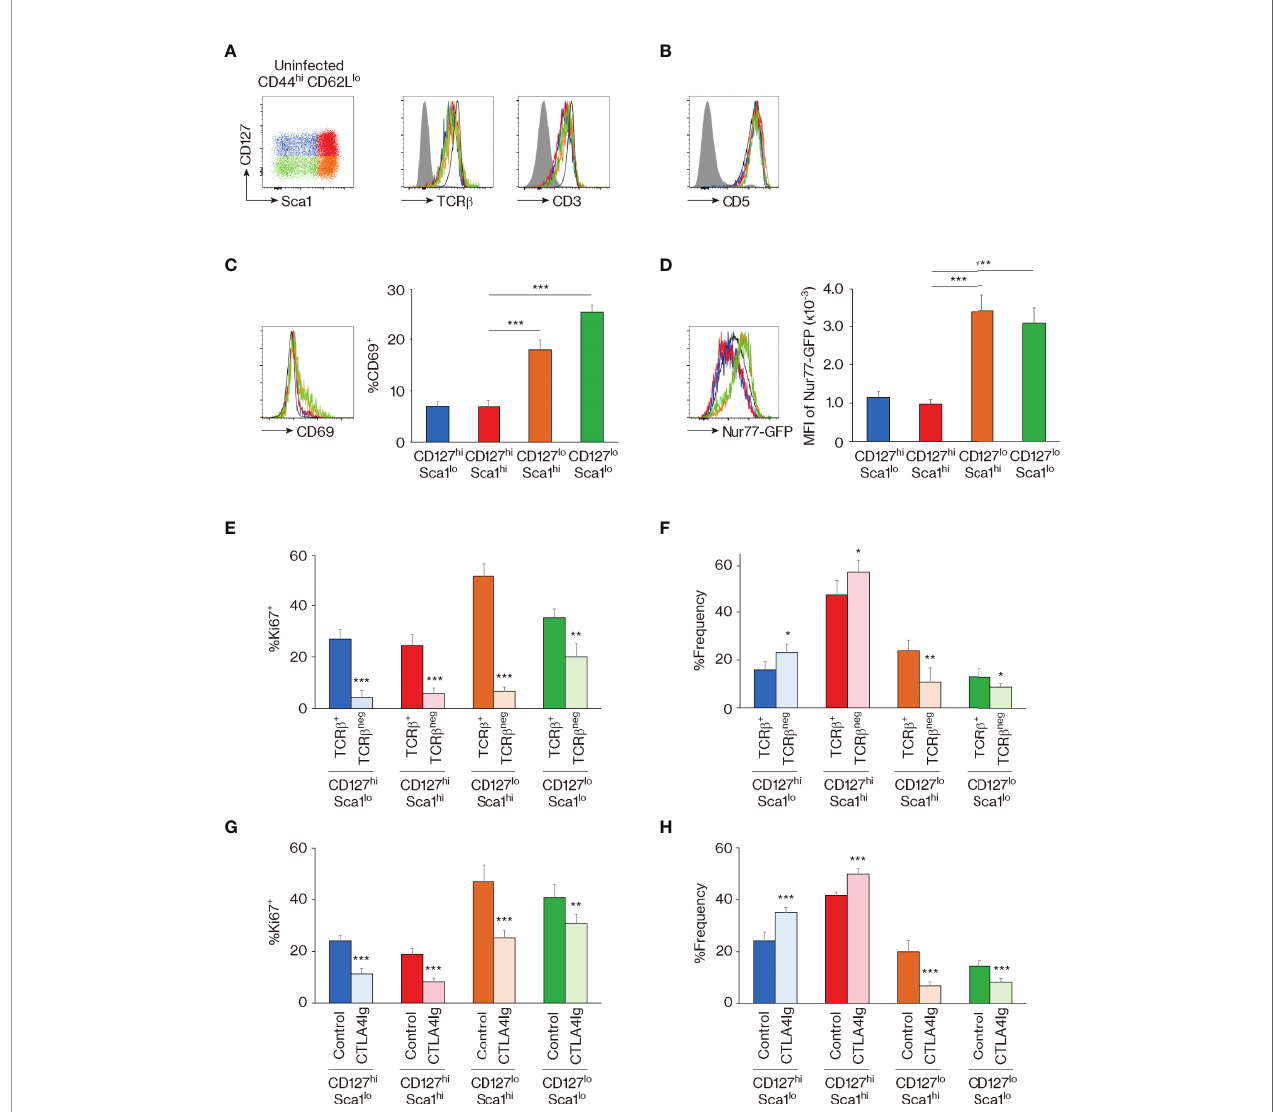
FIGURE 4 | The four memory-phenotype (MP) subpopulations are maintained via T-cell receptor (TCR) and CD28 signaling. (A – D) CD127 lo MP subsets represent cell populations that have recently received TCR signaling. Representative histograms display (A) TCR b , CD3, (B) CD5, (C) CD69, and (D) GFP expression in the indicated MP subpopulations from Nur77-GFP reporter mice, while the bar graphs indicate (C) the frequency (mean ± SD) of CD69 + and (D) the mean fl uorescence intensity (MFI) (mean ± SD) of GFP among the MP subpopulations (n = 5 mice). Filled histograms show negative control staining, whereas black and open histograms display naïve CD4 + T cells. (E, F) TCR signaling is essential for proliferation and dynamic equilibrium of MP subpopulations. CD4-CreERT2 TCR a fl ox mice received tamoxifen (TMX) and were analyzed 10 days later. Bar graphs indicating the frequency (mean ± SD) of (E) Ki67 + cells among both TCR b + and TCR b neg fractions from each MP subset and (F) the indicated subpopulations among the TCR b + or TCR b neg MP cells are depicted (n = 5 mice). (G, H) CD28 signals are critical for optimal maintenance of MP subpopulations. Mice received CTLA4-Ig and were analyzed 10 days later. The bar graphs show the frequency (mean ± SD) of (G) Ki67 + cells among the indicated MP subpopulations from each group and (H) the indicated subsets among total MP T lymphocytes (n = 5 mice). Data are representative of 2 independent experiments. Statistically signi fi cant differences are indicated as * p < 0.05, ** p < 0.01, and *** p <